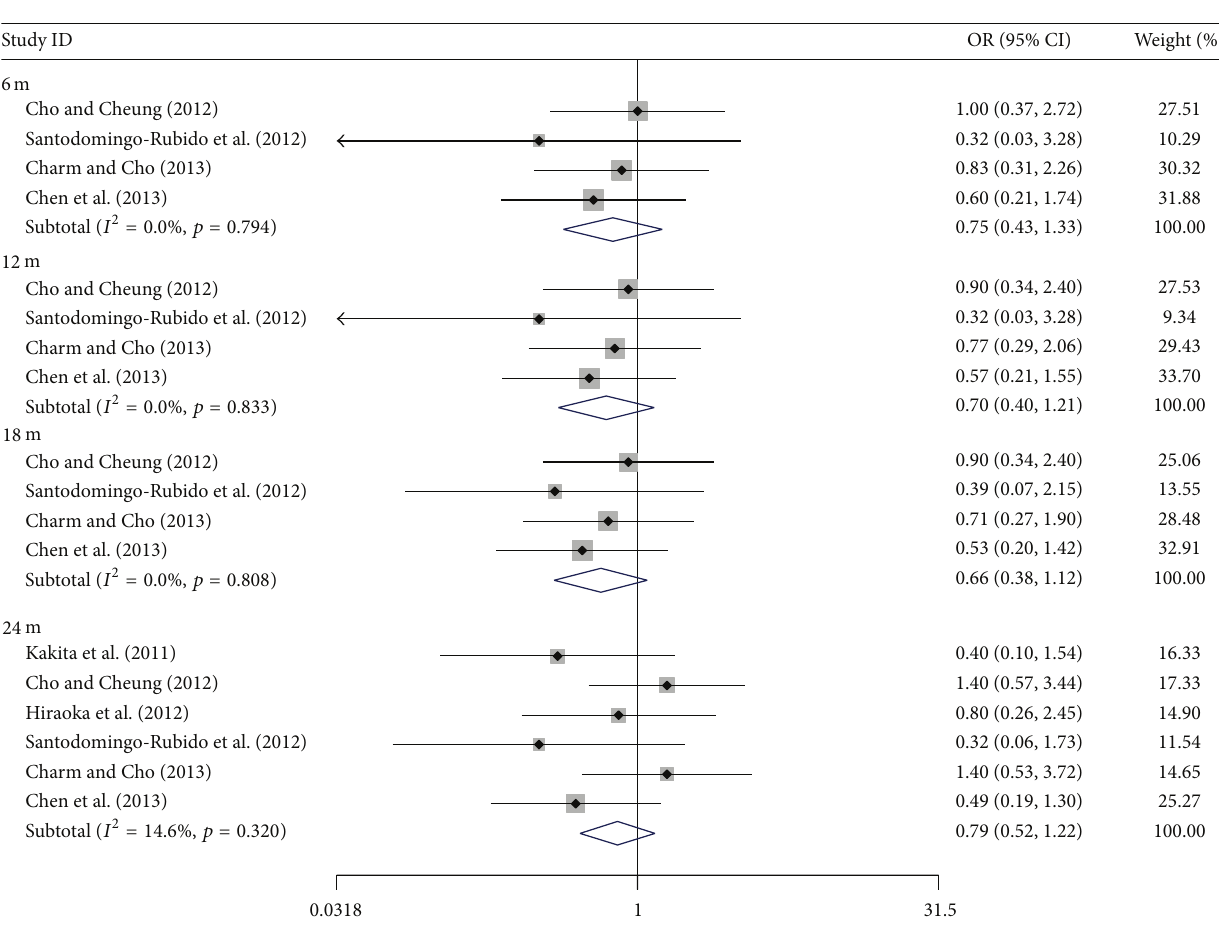
0.1 mm in two years is small in terms of clinical